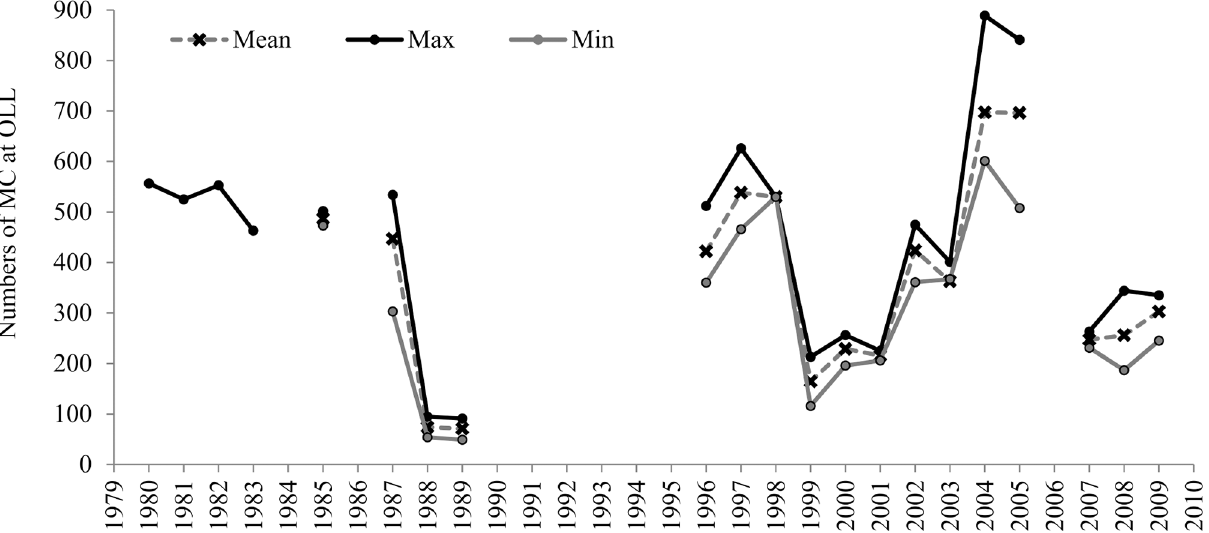
Fig 2. Mother-calf pairs counts at Ojo de Liebre Lagoon. Mean, maximum (Max) and minimum (Min) counts of mother-calf pairs (MC) at Ojo de Liebre Lagoon (OLL) during the month of February; Mean: sum of the total number of whales counted during all the surveys conducted during February divided by the total number of surveys conducted in that month (total whales/total surveys); Max: survey with the maximum number of MC pairs counted; Min: survey with the minimum number of MC pairs